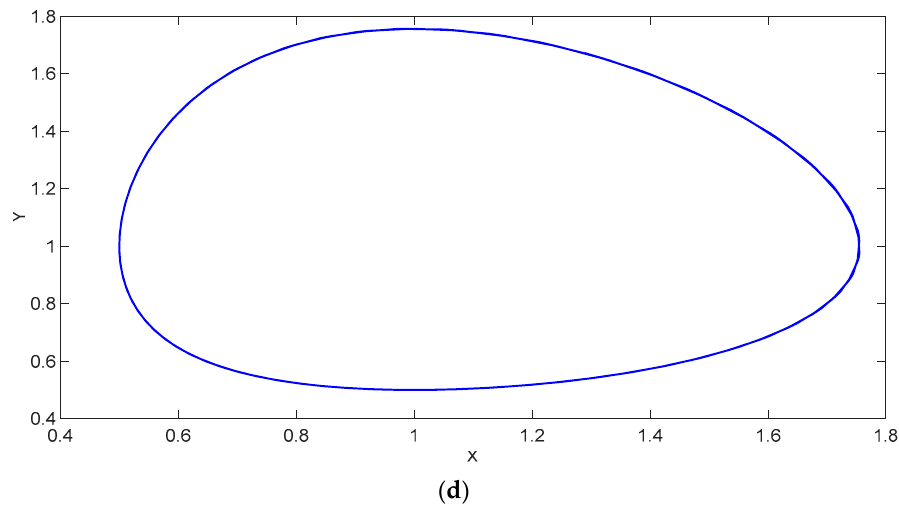
( d ) Figure 8. Concentrations of the variables x and y for case iii (Table 1). ( a ) Scenario VII, ( b ) Scenario Mathematics 2020 , 8 , x FOR PEER REVIEW Figure 8. Concentrations of the variables x and y VIII, ( c ) Scenario IX, and ( d ) phase plane of scenario VII. for case iii (Table 1). ( a ) Scenario VII, ( b ) Scenario VIII, ( c ) Scenario IX, and ( d ) phase plane of